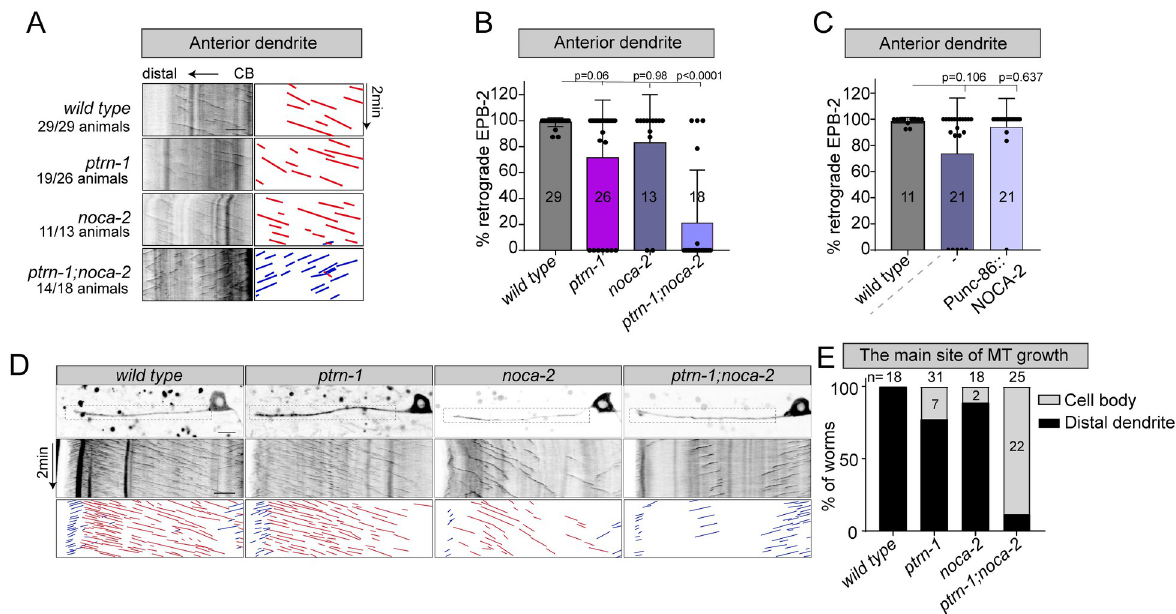
Fig 2. PTRN-1 (CAMSAP) and NOCA-2 (NINEIN) act in parallel to organize microtubules minus-end out in dendrites. ( A - C ) Analysis of microtubule organization in the mature PVD anterior dendrite using EBP-2::GFP to visualize the microtubule plus-end growth events. ( A ) Kymographs illustrating EBP-2::GFP growth events in the PVD anterior dendrite in the wild-type and indicated mutants. The numbers of animals with this phenotype are indicated. ( B ) Quantification of the retrograde growth events in mature PVD anterior dendrite in the wild-type and indicated mutant backgrounds. ( C ) Quantification of the percentage of EBP-2 retrograde growth events in noca-2 mutant with or without the unc- 86 promoter (early expression)-driven rescue construct. Scale, 5 μ m. Analyzed animals were from the L4 or young adult stage; error bars represent SD; statistical analysis, Kruskal–Wallis test followed by Dunn’s multiple comparisons test. Number of analyzed animals is indicated. ( D , E ) Analysis of microtubule organization in the developing PVD anterior dendrite using EBP-2::GFP in indicated mutants. Representative kymographs are shown ( D ), and the main site of microtubule growth events was visually classified ( E ) as mainly in the distal dendrite (distal dendrite) or as coming from the cell body (cell body). Scale, 5 μ m. Error bars represent SD; statistical analysis, Kruskal–Wallis test followed by Dunn’s multiple comparisons test. Number of analyzed animals is indicated. The data underlying the graphs shown in the figure can be found in S1 Data.